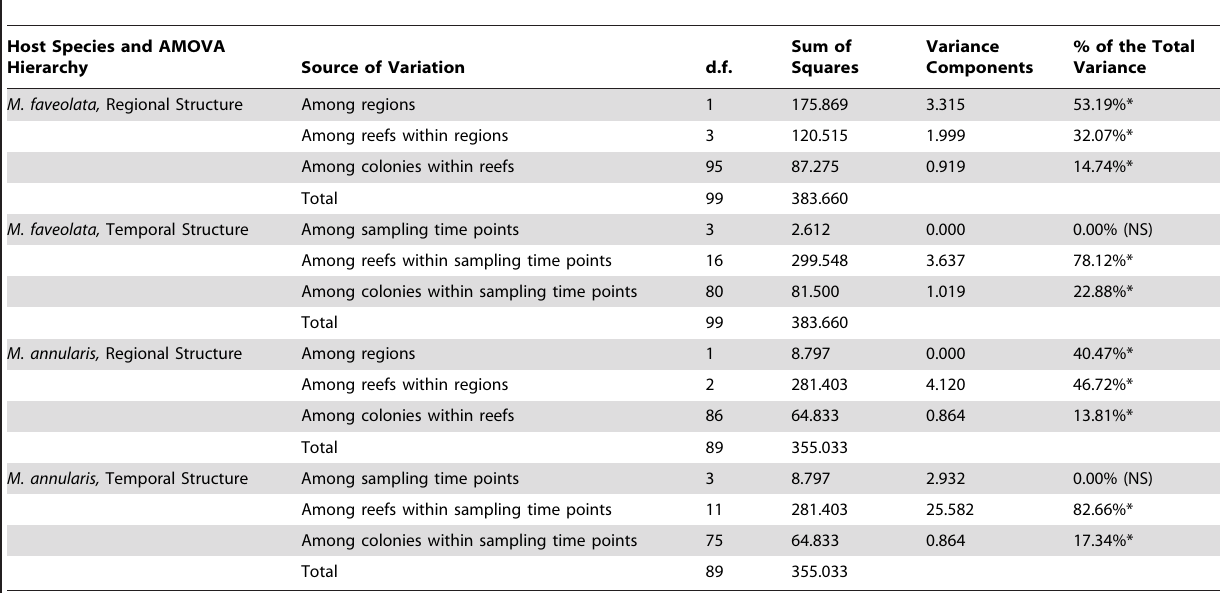
Table 2. Effects of regional and temporal structure on population genetic variation in Symbiodinium Clade B populations of Montastraea spp. as determined by analysis of molecular variance (AMOVA) of three microsatellite loci.